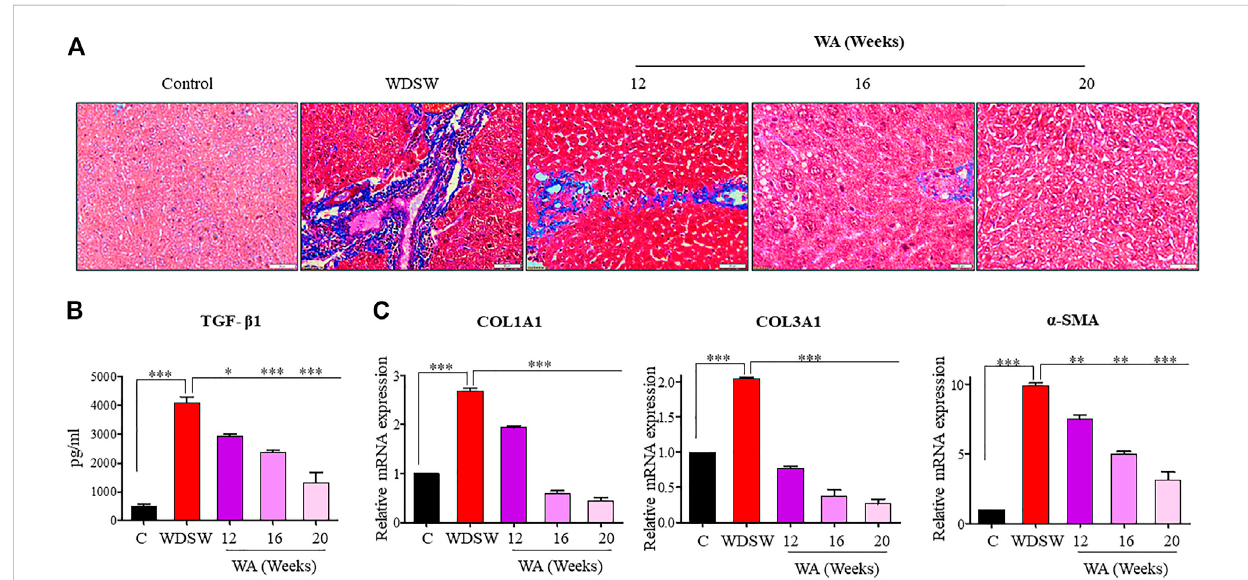
FIGURE 5 WithaferinAinhibitsdiet-induced fi brosisand fi brogenicsignaling. (A) RepresentativeliversectionsstainedwithMasson ’ strichomestain(MTS)witha scale bar of 50 μ M. (B) Secretion of TGF- β 1 by the liver in the withaferin A-treated WDSW-induced NAFLD mouse model measured by ELISA. (C)